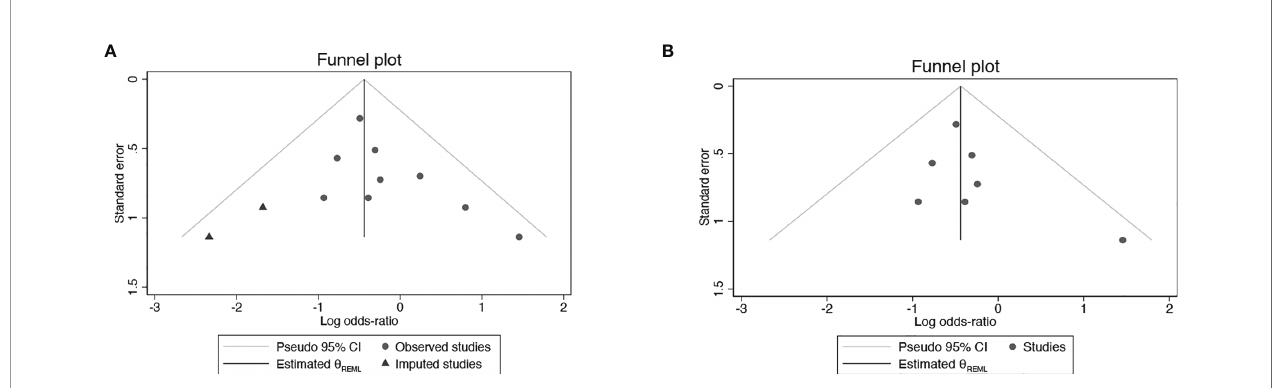
FIGURE 11 | Publication bias with trim and fi ll (A) Mannitol Vs. Non-mannitol (B) Mannitol Vs.